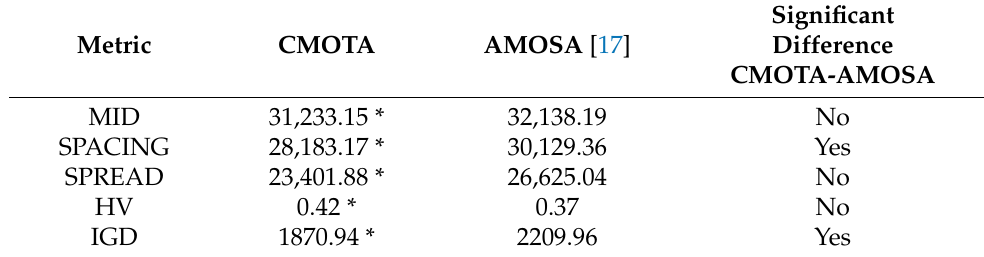
Table 7. Comparison among CMOTA with AMOSA.